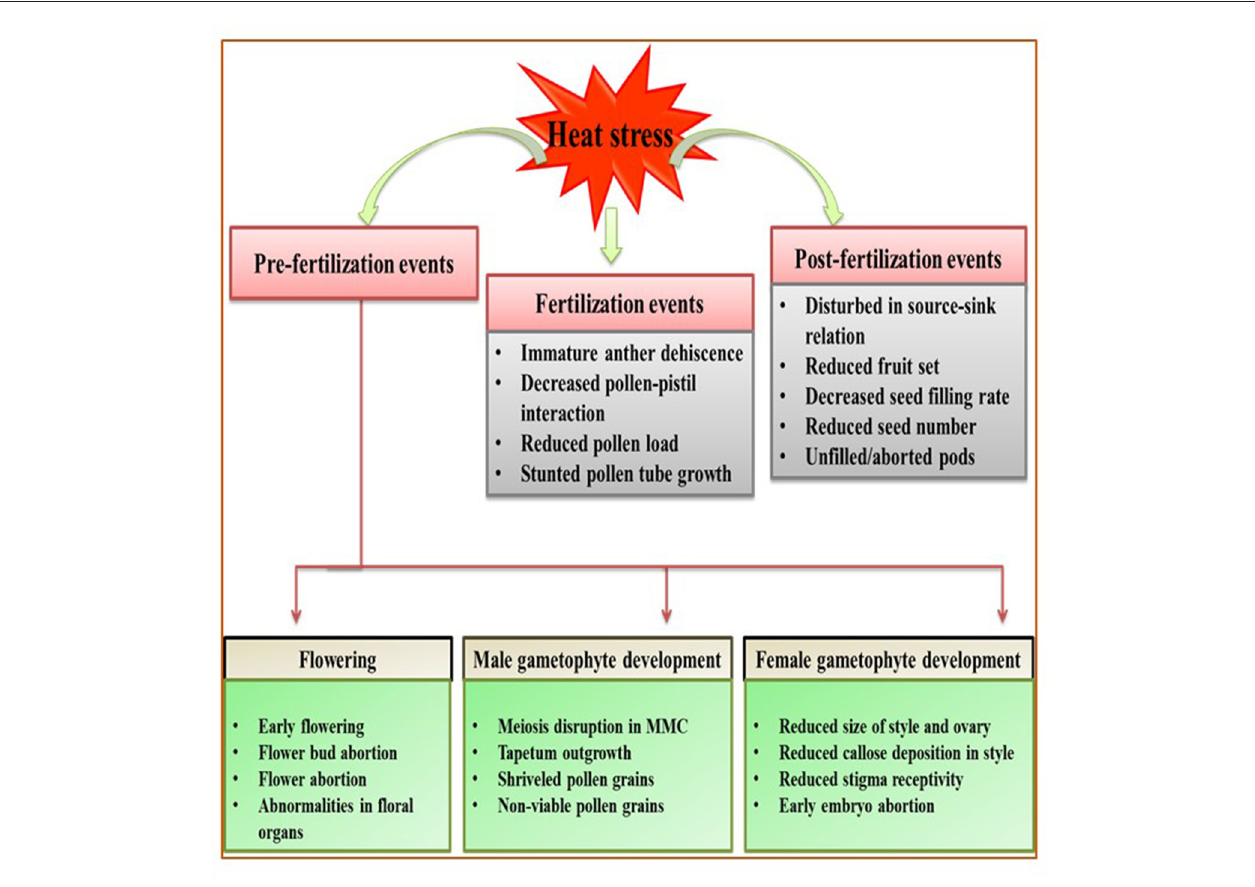
FIGURE 2 | Generalized overview of the effects of heat stress (HS) on the reproductive stage of plants, broadly categorized into three events: pre-fertilization, fertilization, and post-fertilization. Heat stress affects the flowering stage by promoting early flowering and flower bud/flower abortion. During male gametophyte development, heat stress disrupts meiosis and decreases tapetum growth, resulting in shriveled and non-viable pollen grains. During female gametophyte development, heat stress reduces style and ovary size and callose deposition, reduces stigma receptivity, and causes early embryo abortion. Moreover, immature dehiscence and malformed pollen grains result in poor pollination and fertilization. Heat stress during post-fertilization decreases the seed filling rate and disturb source–sink relations, potentially reducing yield manifold.